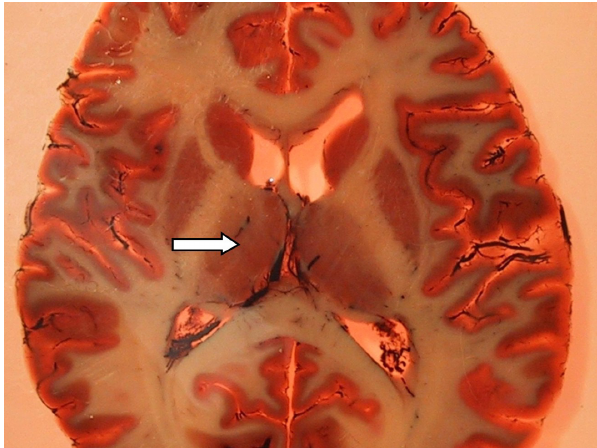
Figure 1 - Photograph of a plastinated brain section from a patient with schizophrenia, showing the situation of the thalamus (arrow), which is lo- cated adjacent to the ventricles. The thalamus is divided into microscopically definable subnuclei (e.g., the mediodorsal nucleus) and has connections to the prefrontal and temporal